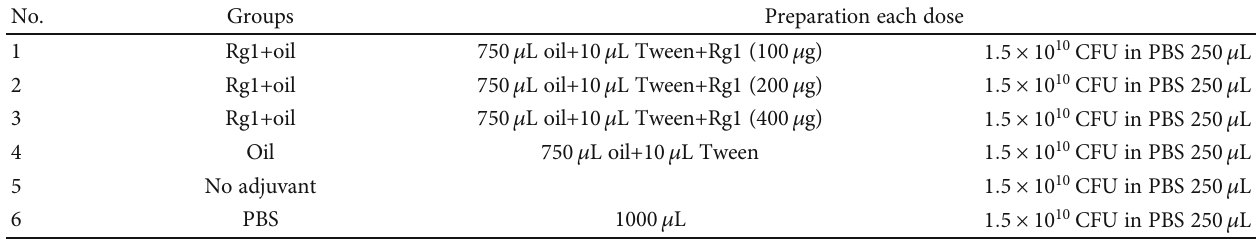
Table 2: Adjuvant vaccines used in Experiment B.